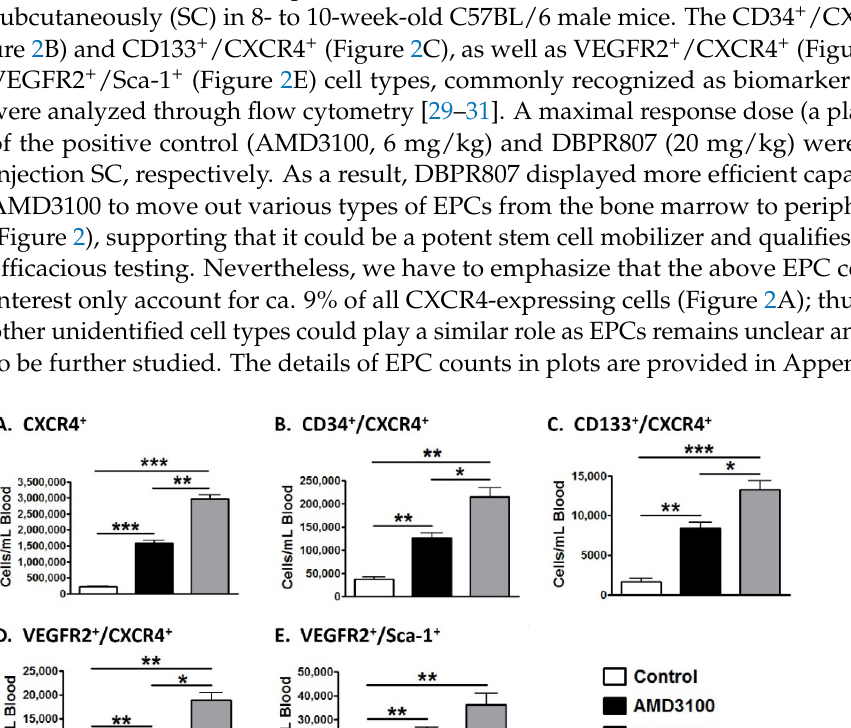
were administered subcutaneously with CXCR4 antagonists AMD3100 (5 mg/kg) or BBPR807 (5 mg/kg), respectively, at 5 min before reperfusion. Evans blue and TTC stain- ing of cardiac tissue were performed 24 h following the surgically induced IR injury in the heart for analysis. Results demonstrated that rats treated with DBPR807 (5 mg/kg, n = 15) preserved far more viable tissue (red) than the control group ( n = 10), as seen in Figure 3B. After quantitative analysis (Figure 3C), the ratio of infarct area to area at risk (AAR) for DBPR807 was significantly reduced to 30%, which was much lower than that of the control group (54%) and AMD3100 treatment group (43%), suggesting that DBPR807 produces a stronger protective effect against IRI than its marketed CXCR4 counterpart AMD3100 un- der the same setting. Figure 3. Infarct size assessment in rats. Rats were treated with vehicle AMD3100/BR (5 mg/kg, SC) or DBPR807/BR (5 mg/kg, SC) at 25 min after LAD artery ligation or DBPR807/AR (5 mg/kg, SC) at 40 min after LAD artery ligation (control, n = 10; AMD3100/BR or DBPR807/BR, n = 15; DBPR807/AR, n = 8). AAR and infarct size were evaluated 1 day after IR injury in heart via Evans blue and TTC- staining; AMD3100 (infarct area/AAR = 43%); DBPR807 (infarct area/AAR = 30%). ( A ) Treatment protocol. ( B ) Viable tissue is red, and the infarct area is white; scale bar = 1 mm. ( C ) Infarct size was determined by the infarct area/AAR ratio and quantified as a percentage. ( D ) AAR/LV area ratio